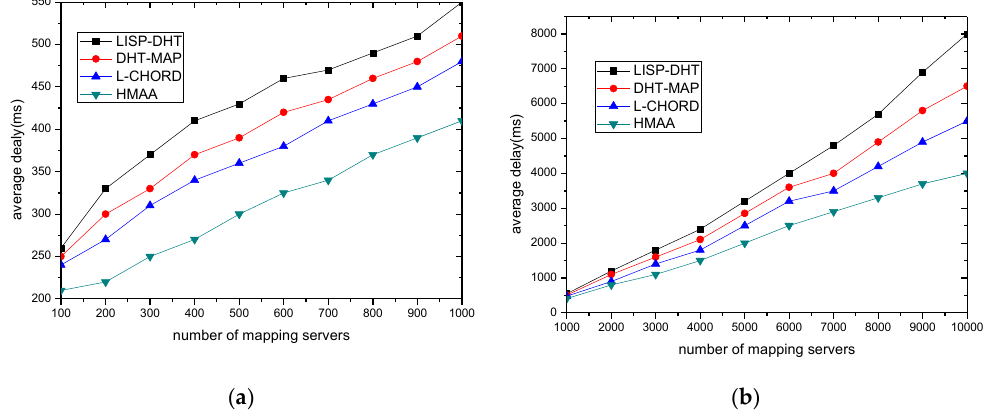
Figure 6. Average mapping delay comparisons: ( a ) Average mapping delay in small-scale networks; and ( b ) average mapping delay in large-scale networks.